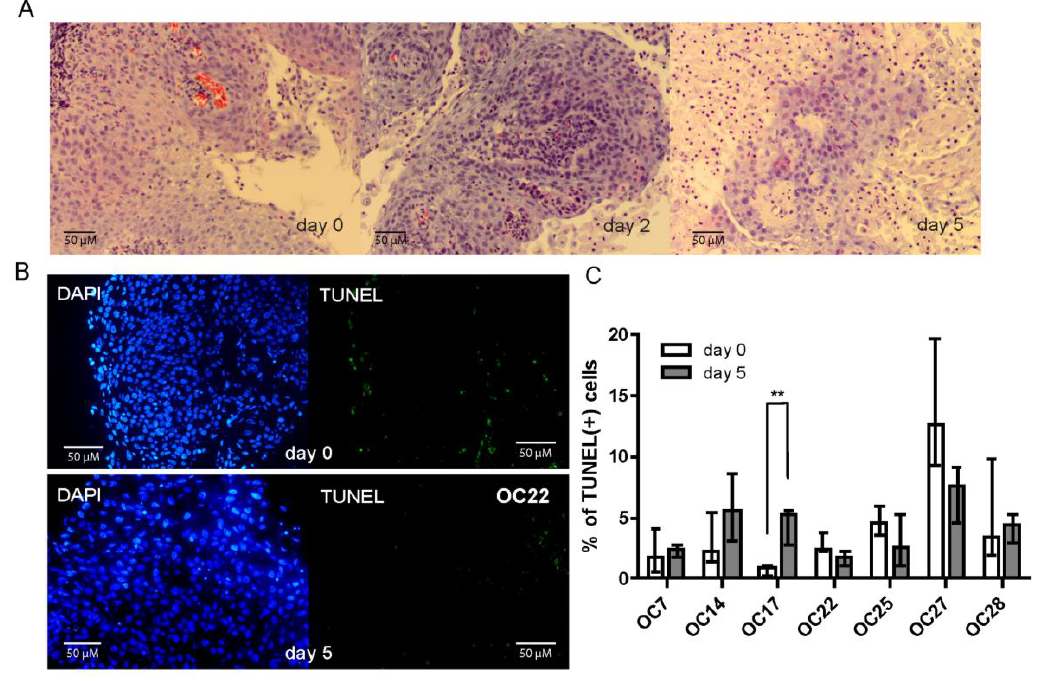
Figure 1. HNSCC tumor slices remain viable during five days of culture. ( A ) Representative H&E staining at day 0 (start of the culture), day 2, and day 5 of ex vivo culture. ( B ) Representative mi- croscopy images of TUNEL staining at days 0 and 5 of ex vivo culture. ( C ) Quantification of TUNEL- positive at the start, and after 5 days of ex vivo culture. Graph bars represent the mean of ≥5 FoV per sample, and error bars show SEM. A t-test was used to assess significance. ** p < 0.01. 3.3. The Proliferative Capacity of HNSCC Tumor Cells Is Retained during Ex Vivo Culture For a comprehensive assessment of IR response, it is crucial that the tumor cells main- tain their proliferative capacity during culture. The EdU incorporation assay was per- formed to assess the proliferation of the tumor cells (cells that are in the S phase during the last two hours of the incubation period) in the organotypic slices (Figure 2A). We ob- served a marked heterogeneity in the percentage of proliferating cells across the samples already at day zero, and that heterogeneity was also seen on day five of ex vivo culture. There was no statistically significant difference between the day 0 and day 5 groups (Figure 2B; p = 0.13). Although the percentage of EdU-positive cells in a few of the analyzed sam- ples showed a statistically significant decrease during five days of ex vivo culture, prolif- eration was not lost in any of the samples (Figure 2C).